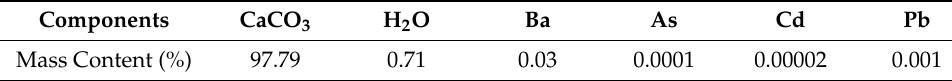
Figure 3. Discarded oyster shells and X-ray diffraction (XRD) analysis. Table 4. Chemical components of oyster shell powder (OSP). Table 4. Chemical components of oyster shell powder (OSP).